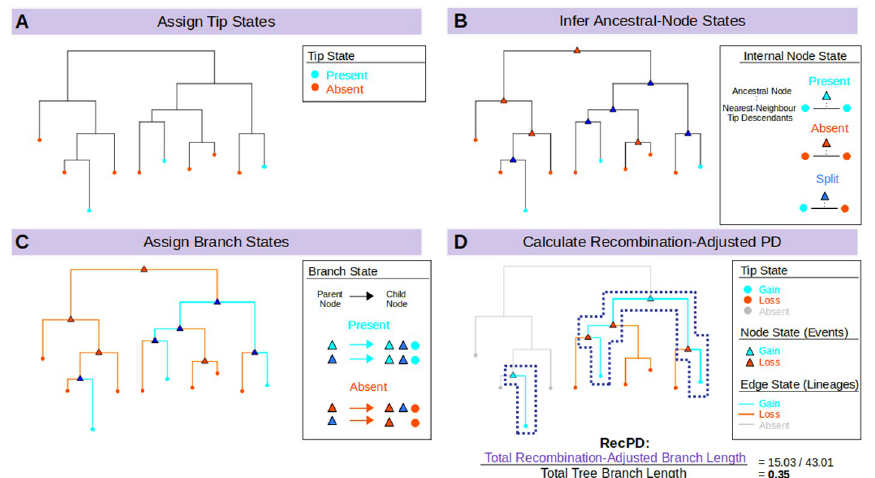
Fig 1. Outline of the RecPD methodology: Calculating recombination adjusted phylogenetic diversities of feature distributions by employing ancestral state reconstructions. (A) Tip states are assigned to a given species phylogenetic tree based on presence (teal), or absence (red) of the gene family of interest. (B) Ancestral node states are inferred using one of there ancestral state reconstruction methods and assigned to either presence (teal), absence (red), or split (blue) states, the latter which indicate potential gain/loss events. (C) Branches are assigned to presence states if they join consecutive presence or split nodes/tips (teal), otherwise they are assigned to absence (red). (D) Gene-family lineages are identified, and split state nodes are assigned to gains (teal) or losses (red). Branches descended from the phylogenetic tree root node where no ancestral presence nodes were identified are assigned to absence (grey). RecPD is then calculated as the sum of gene family lineage branch-lengths normalized by the total branch-lengths of the phylogenetic tree.